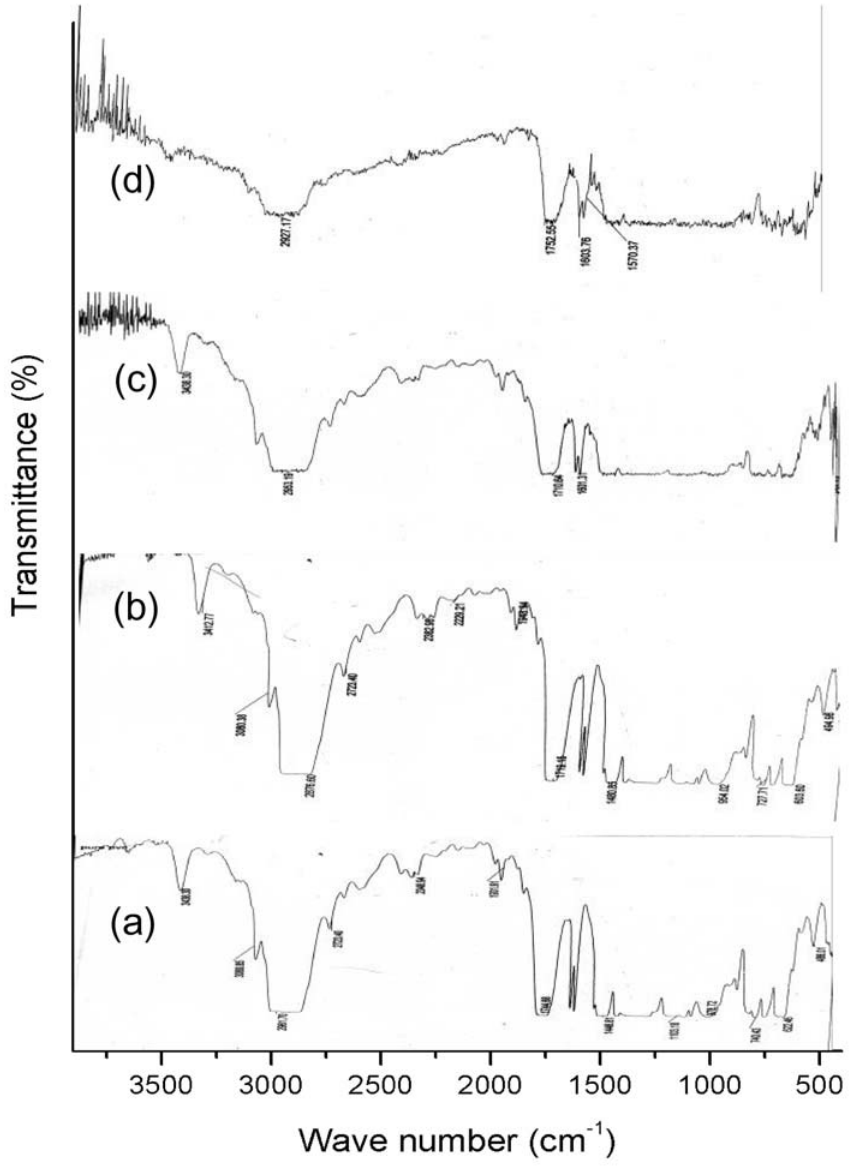
Fig. 8 FTIR spectra of (a) Pure PVC, (b) PANI 2 and (d) PANI 20%